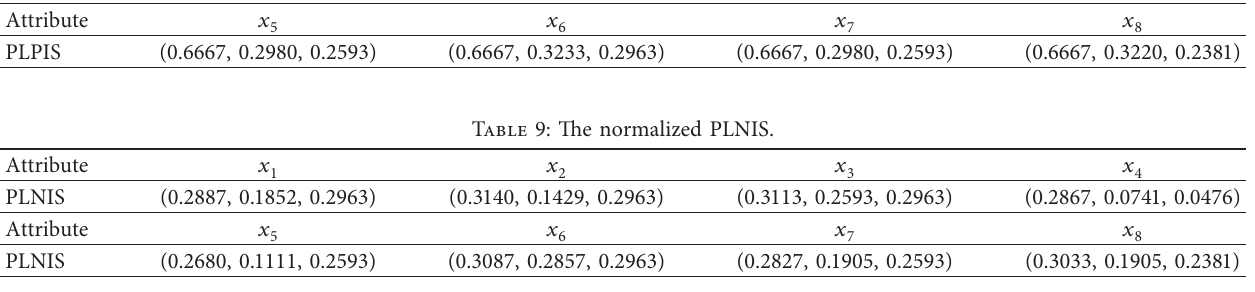
Table 10: The results of d ( A